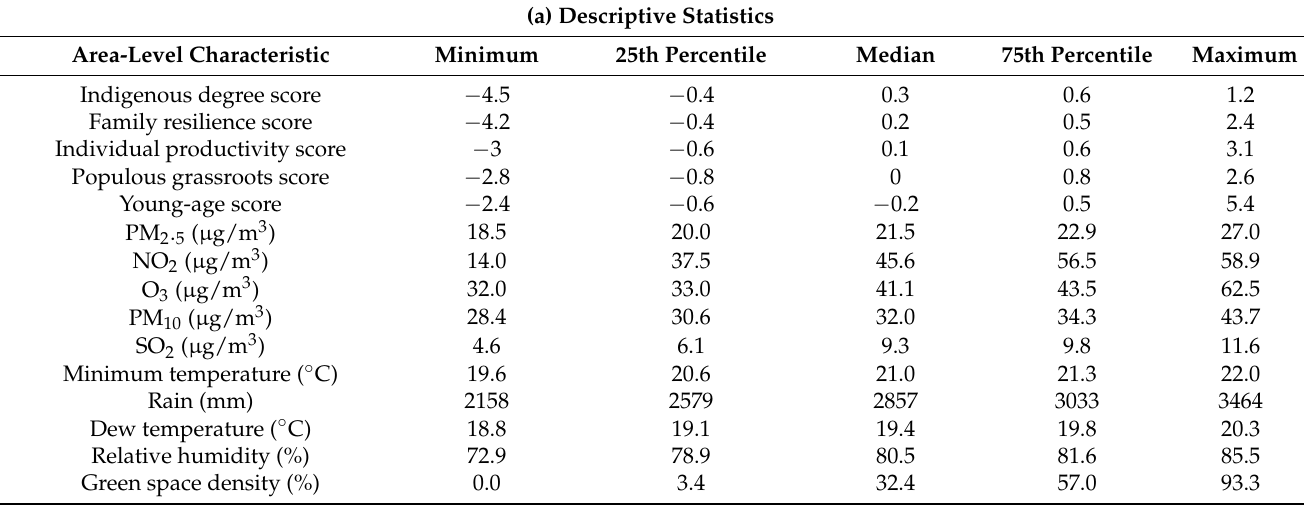
Table 1. (a) and (b): Descriptive statistics and Pearson correlations of socioeconomic variables and environmental exposures in Hong Kong in